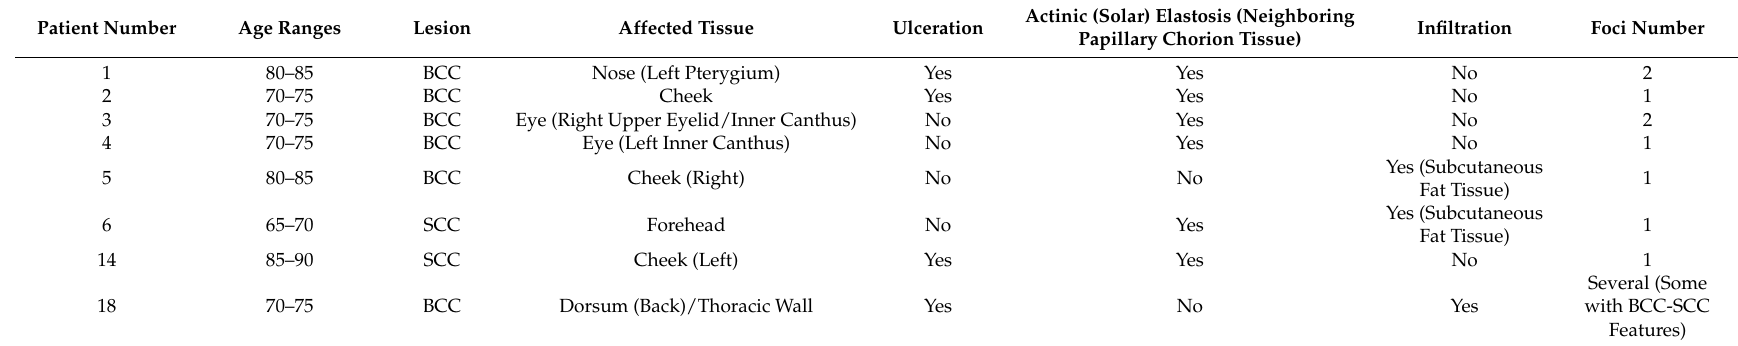
Table 2. Clinical and biological (tumor) characteristics of BCC and SCC Greek patients herein studied. Patient number, age ranges, lesion, affected tissue, ulceration, actinic (solar) elastosis, infiltration, and foci number are reported.